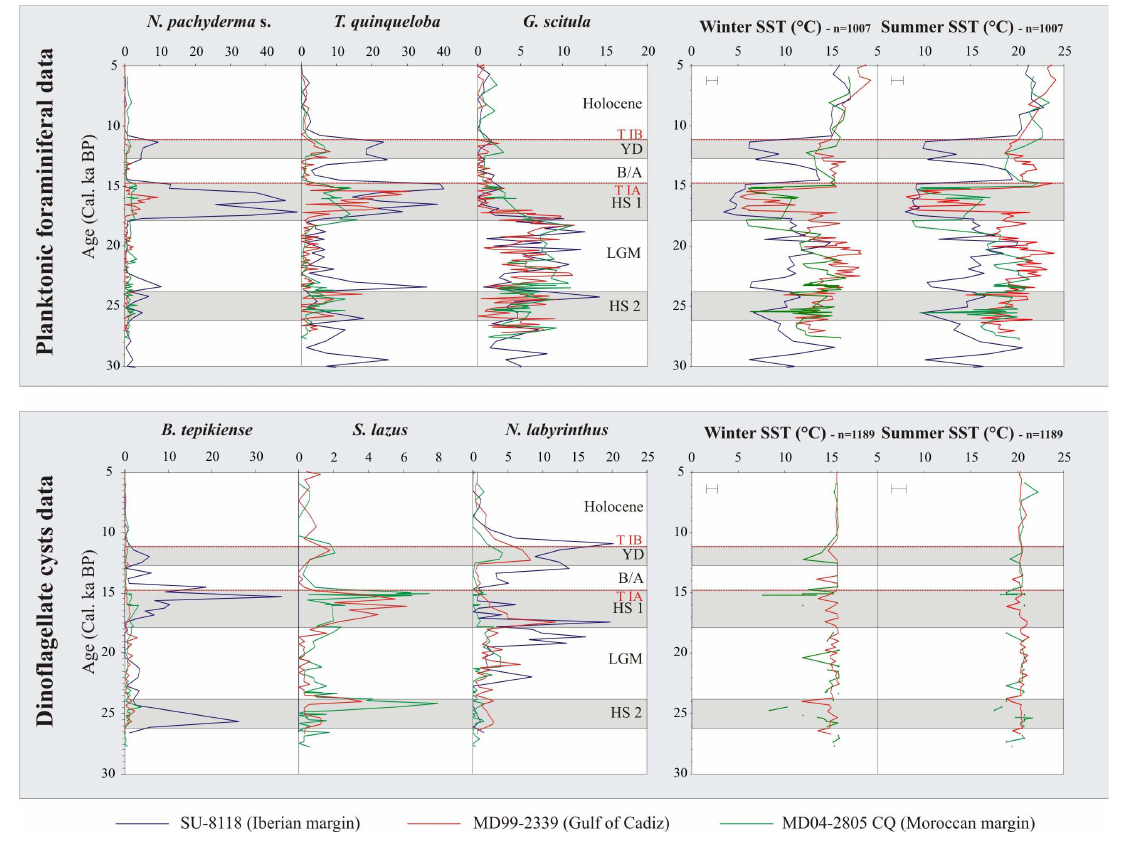
Figure 81352 Fig. 8. On each graph, relative abundances (%) of selected planktonic foraminiferal and dinocyst species are depicted for the three cores with the same percentage scales. These data allow materializing the hydrological front in the NE subtropical Atlantic over the last 30ka. The color code is noted on the figure. Reconstructions of Winter and Summer SST with dinocysts and foraminifera are also shown in the figure with error bars, except for the dinocyst SST reconstructions of core SU-8118 (too few data